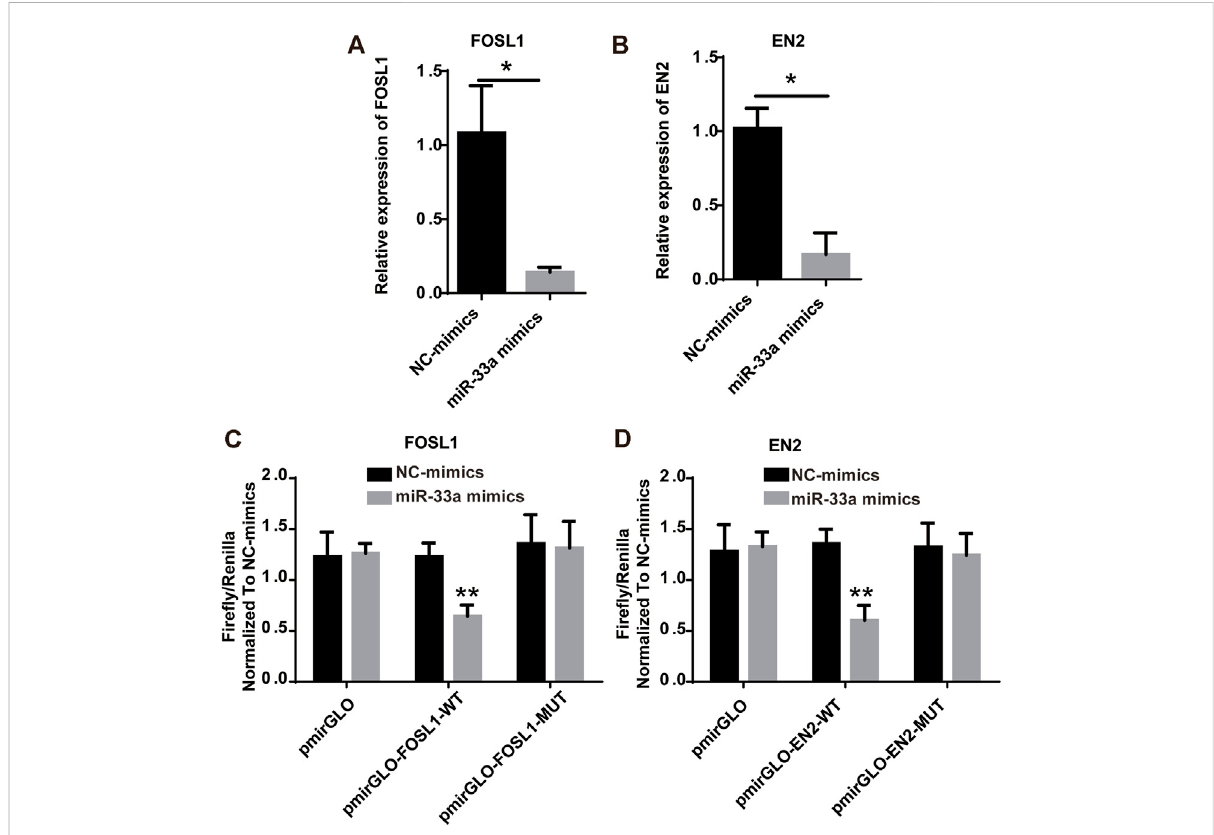
FIGURE 7 Hsa-miR-33a targets and regulates the expression of FOSL1 and EN2. (A) RT-qPCR results indicate that FOSL1 expression is lower in miR-33a- treatedgliomacelllinesthaninthecontrol. (B) RT-qPCRresultsindicatedthatEN2expressionwaslowerinmiR-33a-treatedgliomacelllinesthanin the control. (C) Dual-luciferase reporter gene system indicates the targeting relationship between FOSL1 and hsa-miR-33a. (D) Dual-luciferase reporter gene system indicates the targeting relationship between EN2 and hsa-miR-33a. *- p < 0.05 and **- p <